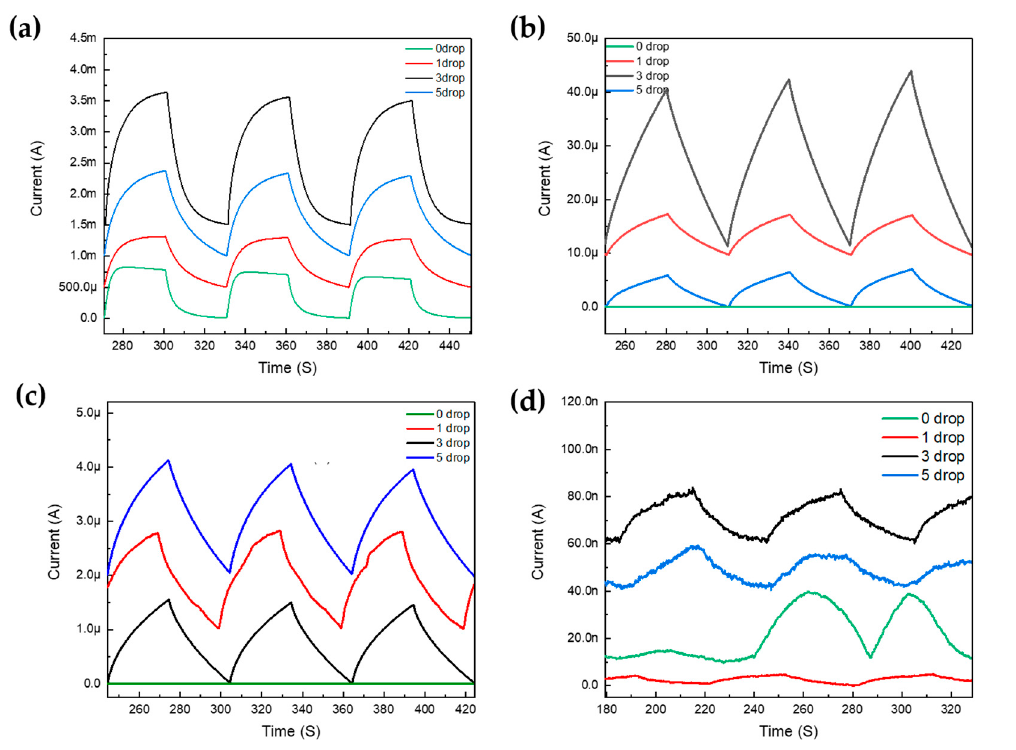
Figure 7. The photoresponse of ZnO NRs photodetector with various amounts of drops (0, 1, 3, and 5 drops) of BIQ solution under ( a ) UV, ( b ) white, ( c ) green, and ( d ) red LED illumination. Table 2. Comparison of photosensitivity of BIQ/ZnO NRs and BIQ-TIPs/ZnO NRs devices under UV and green LED illumination.